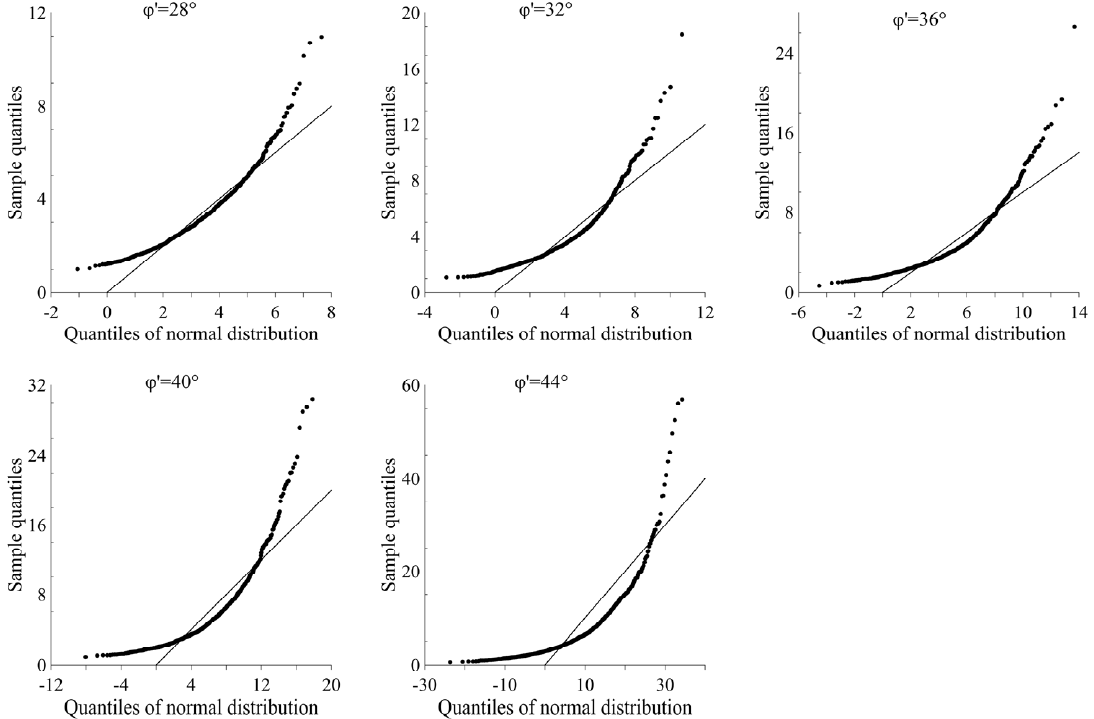
Figure 6. Quantiles and quantiles (Q-Q) plots of normal distribution.